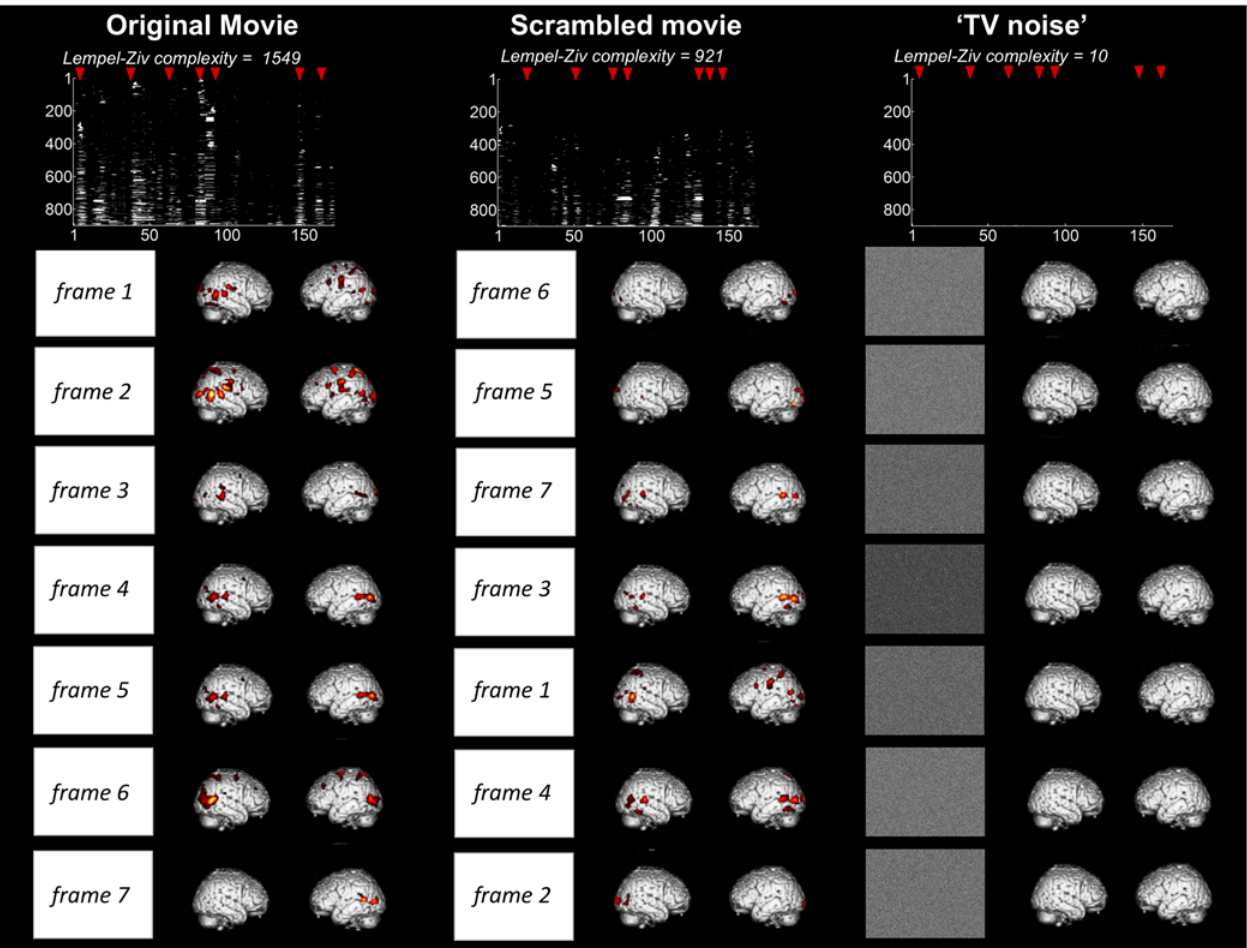
Fig 3. Lempel-Ziv complexity of brain activity correlates with stimulus set meaningfulness — comparison to a black screen baseline. Results shown for a representative subject (same subject as for Fig 2). For each condition, rectangles in the left column show exemplar pixels at the center of the screen of each frame, illustrating that all stimulus set present a high level of physical differentiation over time. In contrast, brain activity patterns over time are highly differentiated in the movie condition, intermediately differentiated in the scrambled movie condition, and very similar to one another in the ‘ TV noise ’ condition. Brain maps are here expressed in terms of significant changes in activity as compared to a black screen baseline (F-test, thresholded at whole brain FWE corrected p < 0.05 for each frame). Top panel displays binarized spatio-temporal activation/deactivation matrices obtained for the 3 conditions after statistical thresholding was applied: a value of 1 was assigned to above threshold voxels for each scan, and a value of zero to voxels below threshold. For display purposes, binarized activation matrices are displayed only for the voxels that show at least once a significant activation in the movie (data dimension reduction from 94000 to ~7000 voxels). Lempel-Ziv complexity was computed at the whole brain activation matrix encompassing 94000 voxels in each condition.